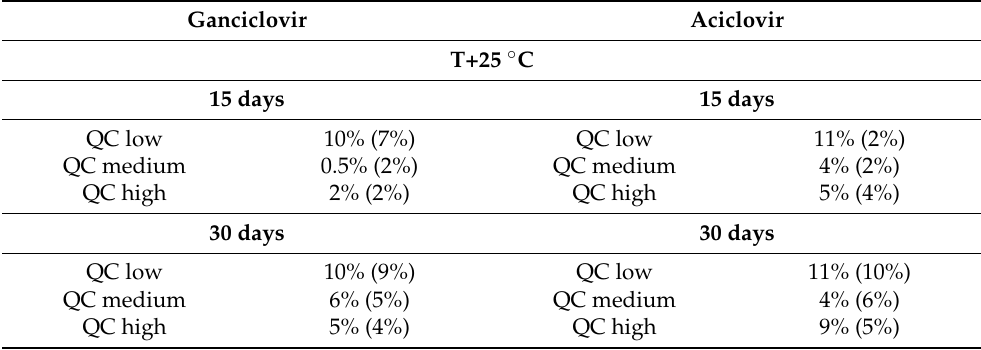
Table 2. Stability of ganciclovir and aciclovir measured on DPS. Results are expressed as the accuracy and CV percentage (CV%) (CV% is the coefficient of variation percentage).